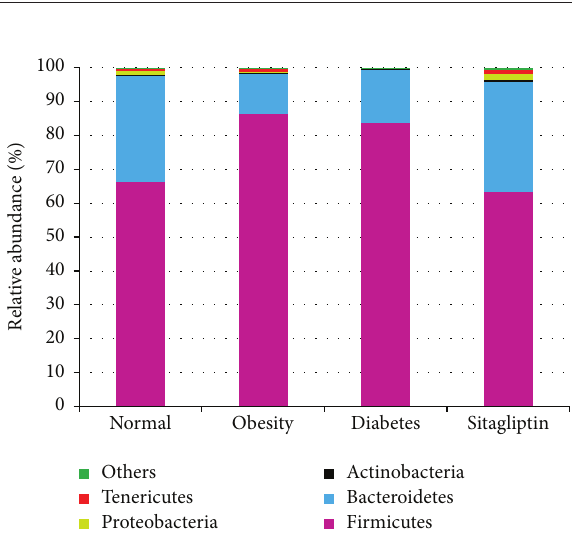
Figure 2: Relative abundance of different bacterial phyla in micro- biota of four conditions.